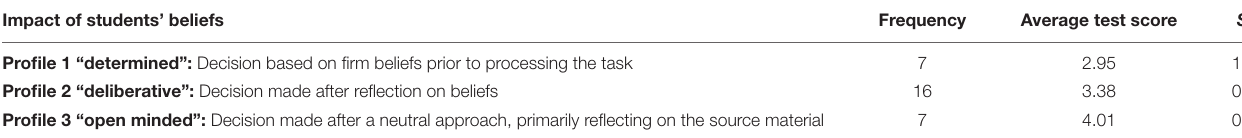
TABLE 3 | Means of task performance of different profiles.